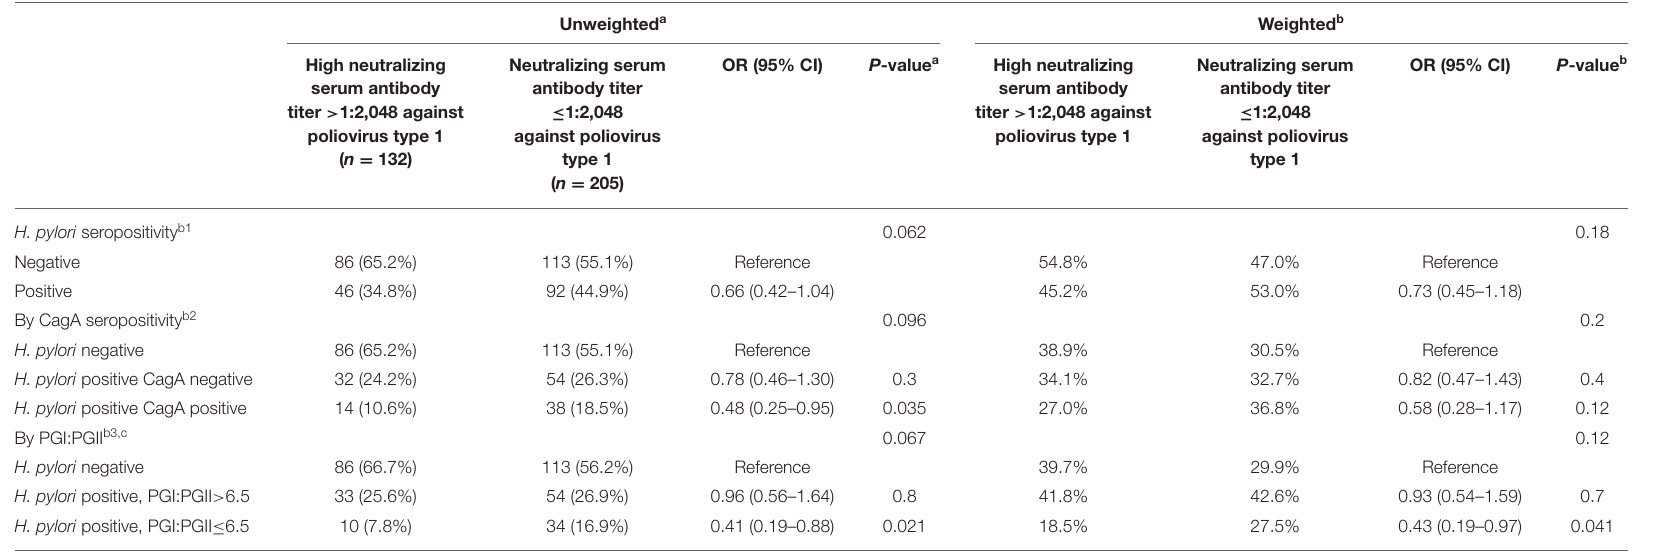
TABLE 2 | Associations of H. pylori IgG seropositivity and serum pepsinogens, with high serum neutralizing antibody level against poliovirus type 1 vaccine strain. Unweighted a Weighted